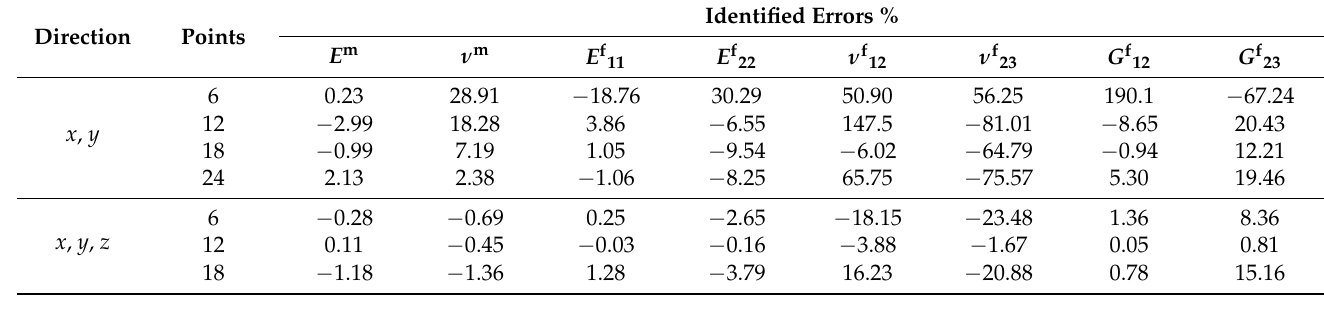
Table 5. Identified errors varying with amount of measuring points.